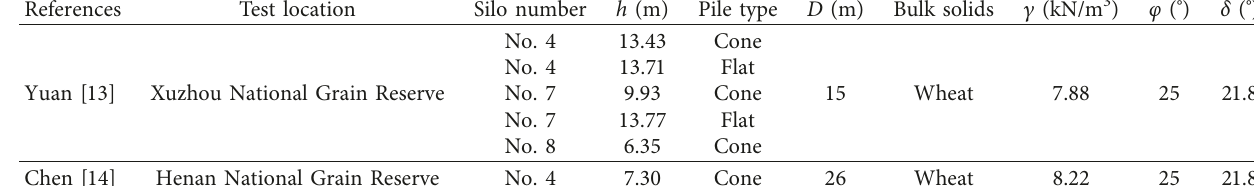
Table 2: Geometrical data and material properties of squat silos.